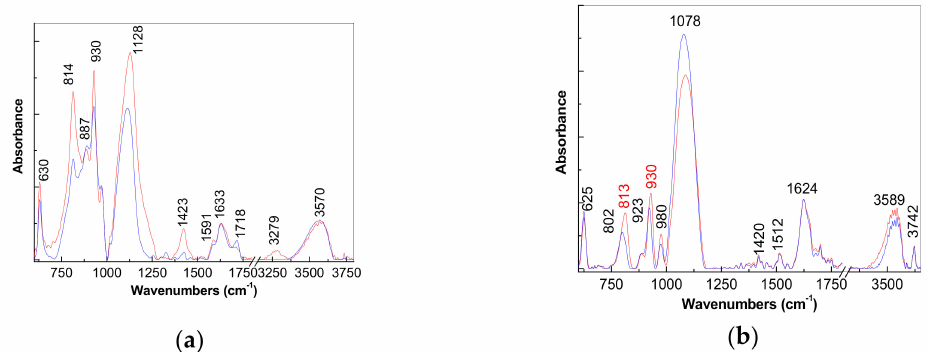
Figure 10. The IR spectra of P5A1N electrochemical synthetized onto the blank Au electrode ( a ) and the Au electrode covered with the RGO sheets ( b ) by recording 5 (blue curve) and 25 (red curve) cyclic voltammograms.